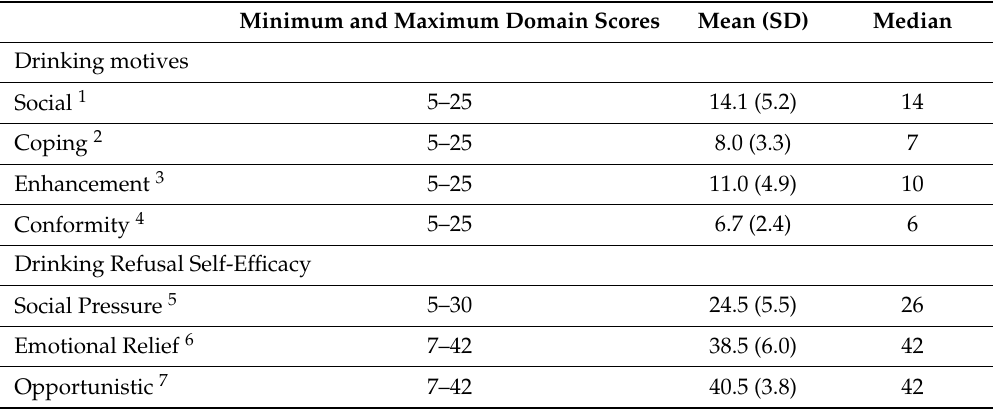
Table 4. Drinking motives and drinking refusal self-e ffi cacy scores of nonpregnant sexually active women ( n = 517).